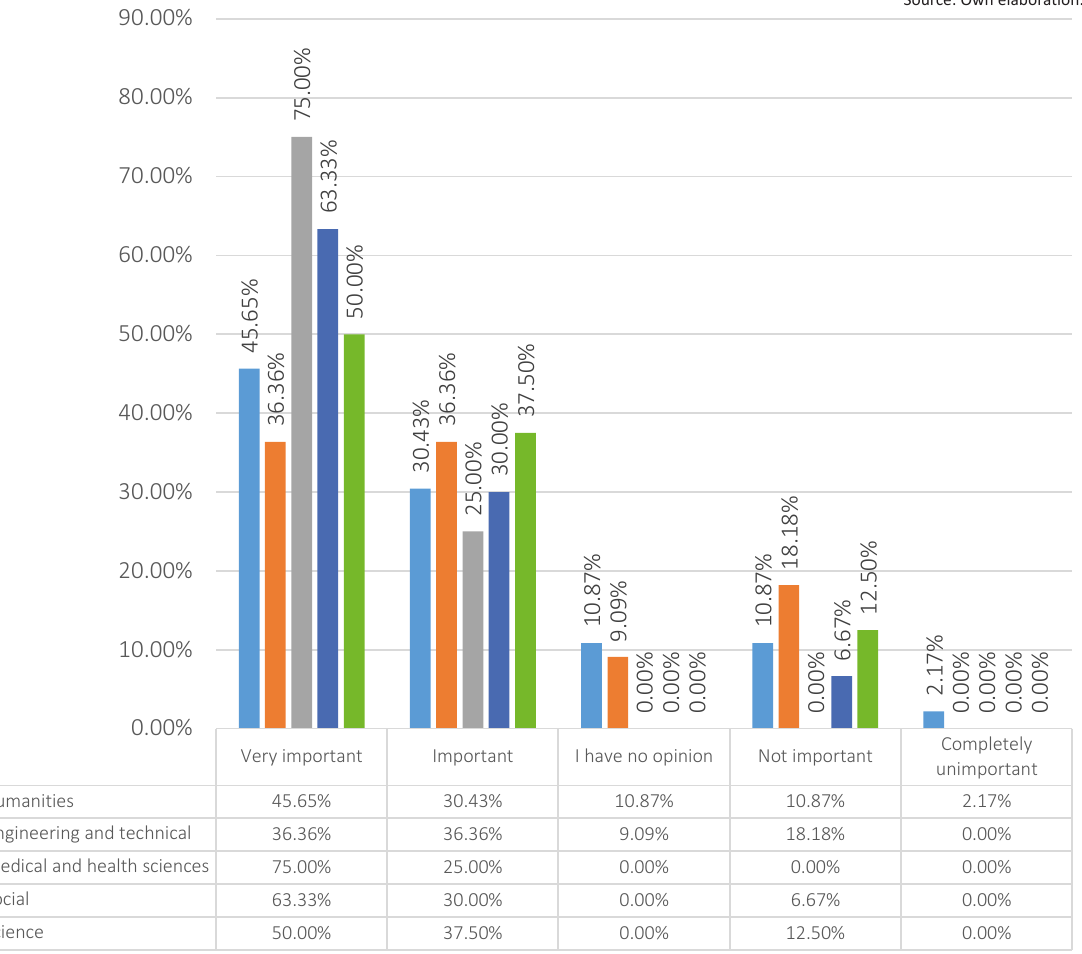
Figure 8. Assessing the value of honesty in the group of subordinates broken down by education fields completed at the first cycle of studies